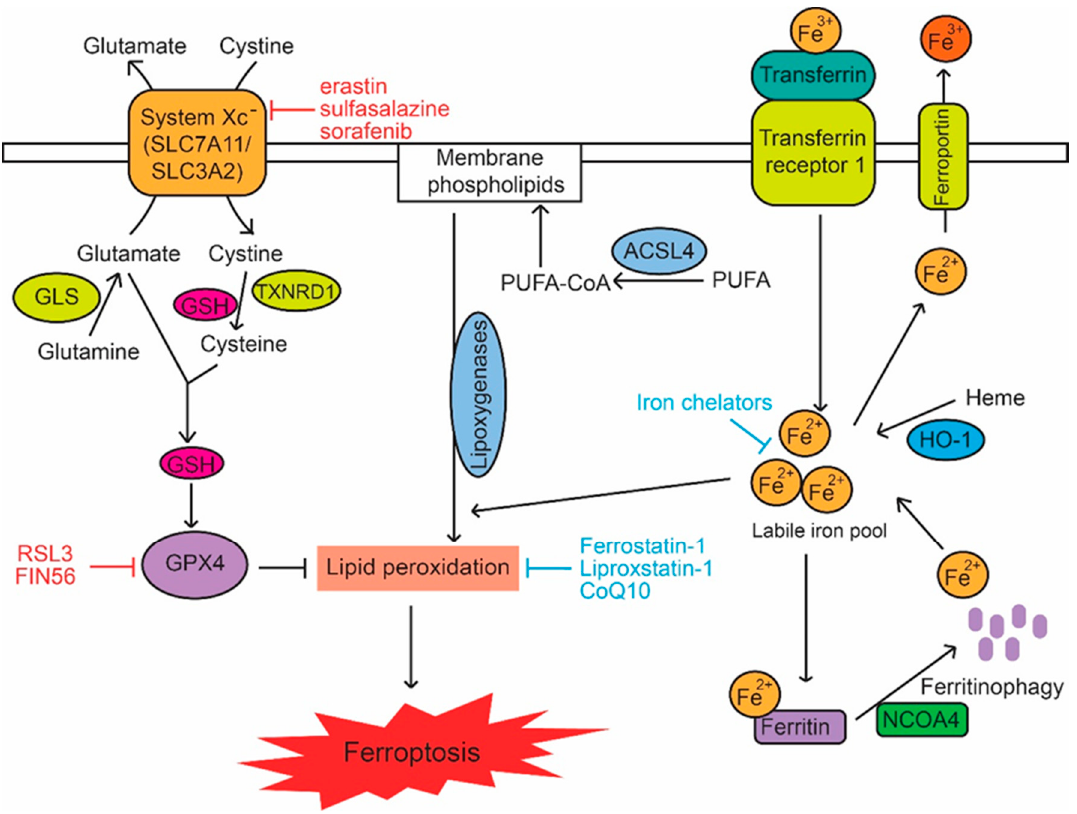
Figure 2. The signaling pathways in ferroptosis. The metabolic pathways involved in metabolism of cystine and glutamine, GSH, PUFAs and iron modulate lipid peroxidation in cells to regulate ferroptosis. CoQ10: coenzyme Q10; GLS: glutaminase; GSH: glutathione; PUFA: polyunsaturated fatty acid; PUFA-CoA: PUFA-coenzyme A.